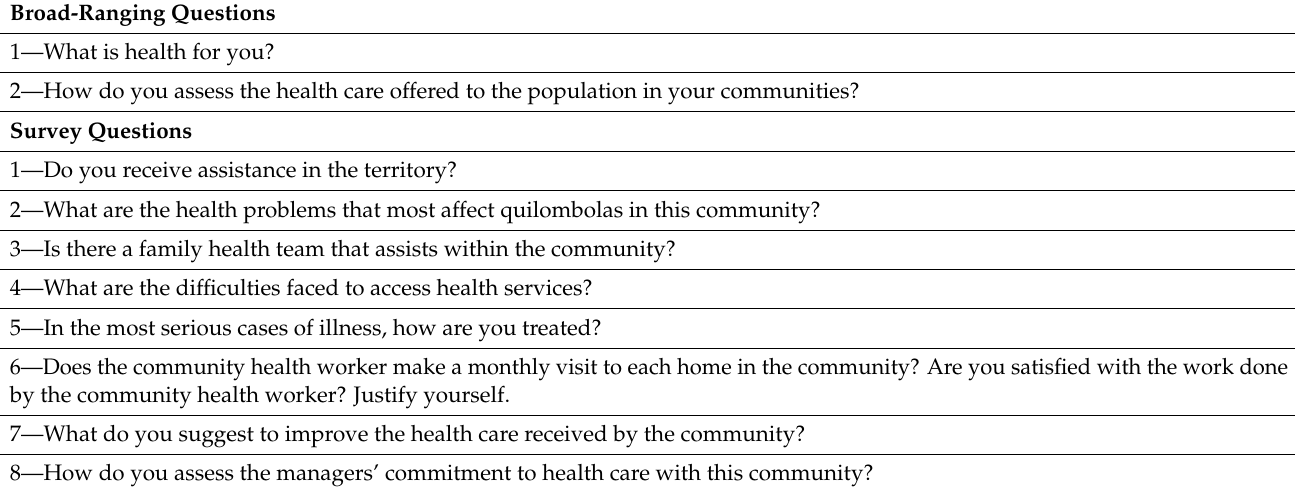
Table 1. Interview script to assess access to health services and assistance offered to remain quilombo communities in the northern region of the state of Tocantins,